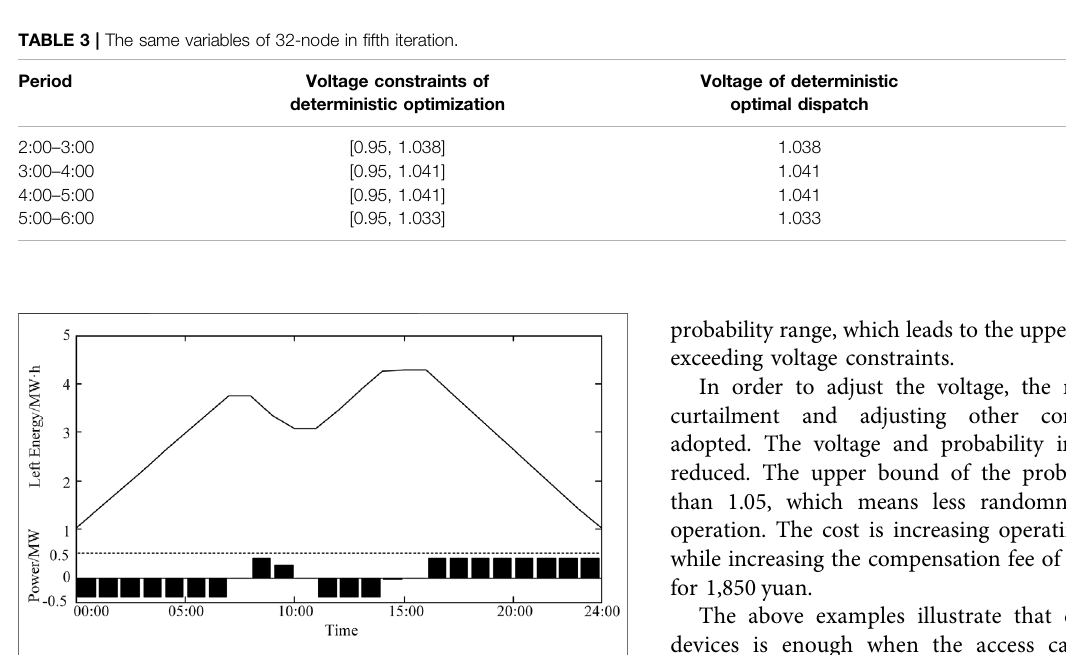
FIGURE 11 | Residual energy and power of the energy storage system.